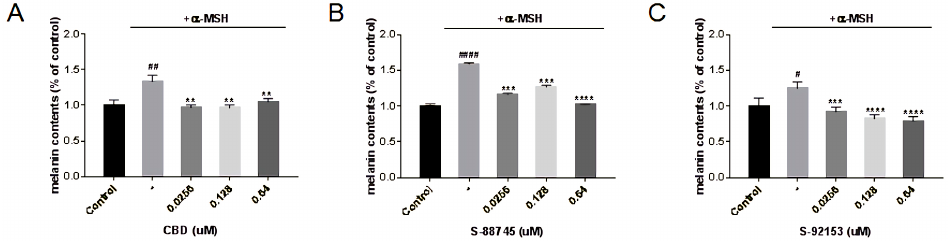
Figure 16. Inhibition of ( A ) CBD, ( B ) S-88745 and ( C ) S-92153 on α -MSH-induced melanogenesis in B16F10. The control group was not stimulated by α -MSH. The α -MSH -treated group (-) was stimulated by α -MSH to produce pigmentation. The experiments were repeated three times. Each bar illustrates the average ± standard deviation (SD) counted from three experiments. p < 0.05 was considered statistically significant. ** p < 0.01 compared to the α -MSH − treated group; *** p < 0.001 compared to the α -MSH − treated group; **** p < 0.0001 compared to the α -MSH − treated group; # p < 0.05 compared to the control group; ## p < 0.01 compared to the control group; #### p < 0.0001 compared to the control group.